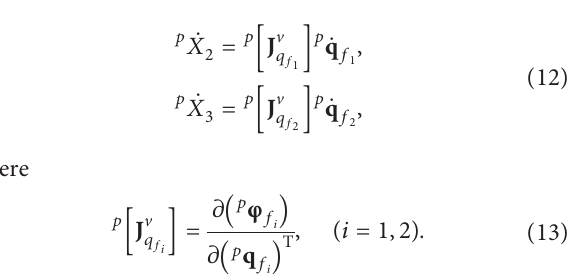
Figure 2: The mobile impact motion